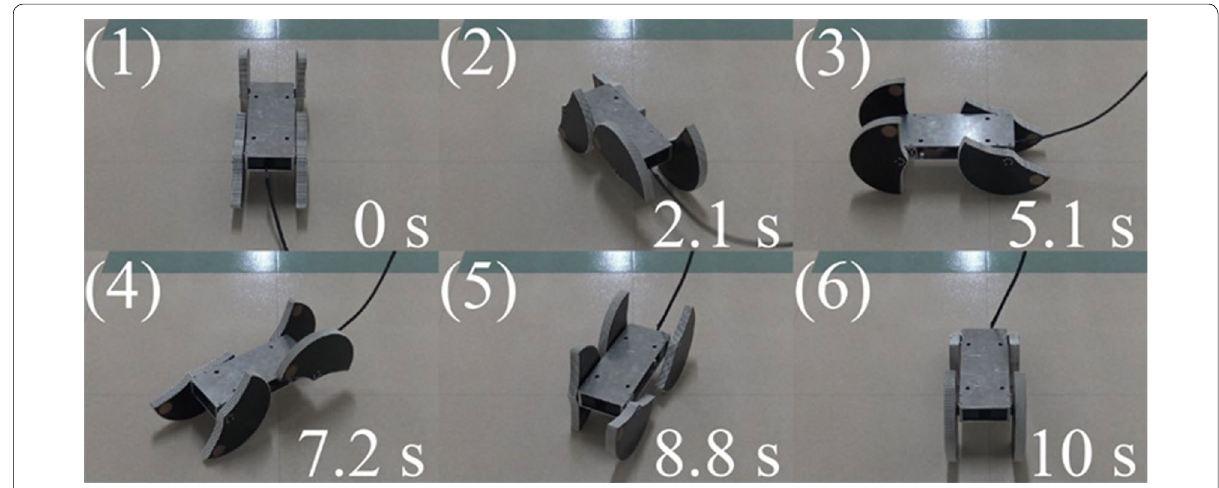
the butterfly gait. This performance is higher than a robot with circular wheels or grouser wheels. We also con- firmed that movement without upward and downward motion is possible on flat ground by the crawl gait. We proposed a new algorithm of turning motion and verified that the prototype model could turn without falling. We also confirmed that it is possible to continuously change from forward turn to pivot